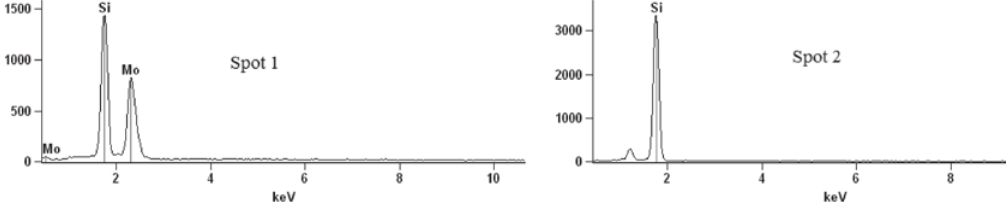
Fig. 4: EDS analysis of coating